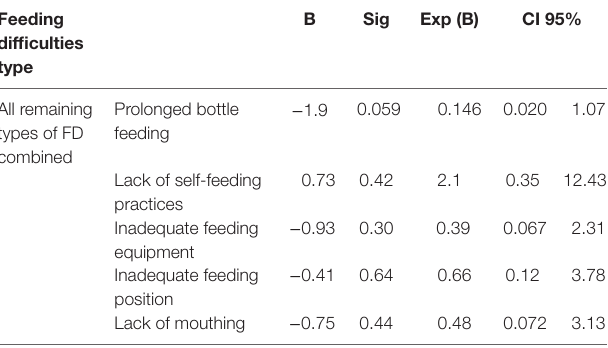
TaBle 2 | Multinomial logistic regression results.